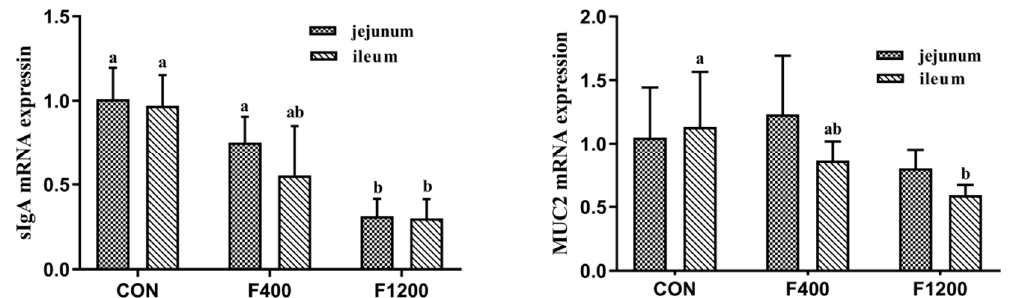
Figure 3. Effect of dietary fluoride levels on the mRNA expression levels of sIgA and MUC2 in jejunum and ileum of laying hens ( n = 6 in each group). Values were showed as the means and SD ( n = 6). ( a , b ) Means without common letters above the histogram differ significantly ( p < 0.05). sIgA, Secretory immunoglobulin A; MUC2, Mucin 2. CON, the control group, basal diet; F400 and F1200, diets supplemented with 400, and 1200 mg F/kg feed from sodium fluoride, respectively.